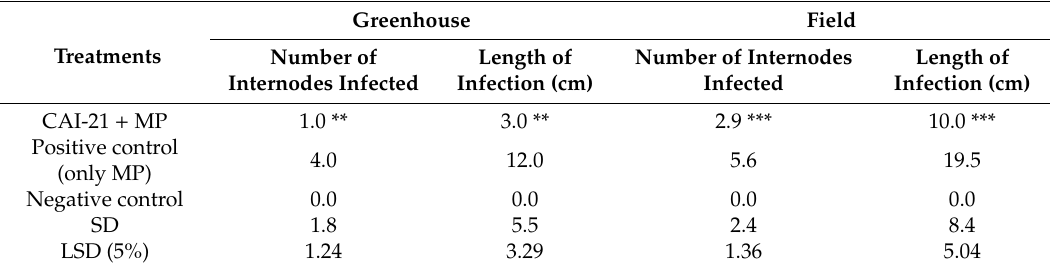
Table 3. Evaluation of S. albus CAI-21 for its biocontrol potential against charcoal rot of sorghum under greenhouse and field conditions.